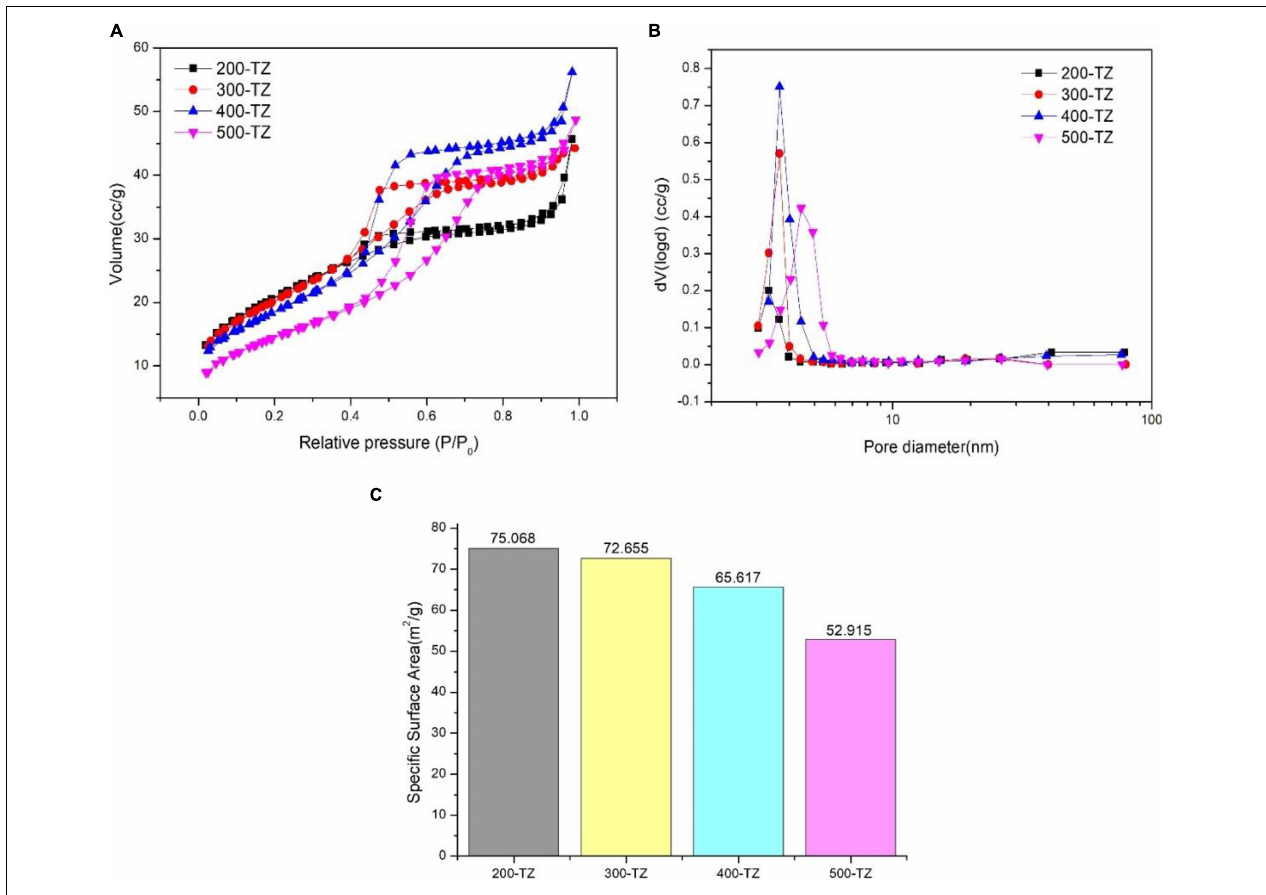
FIGURE 4 | BET analysis results: (A) isotherm adsorption-desorption curve; (B) pore size distribution curve; (C) specific surface area diagram.